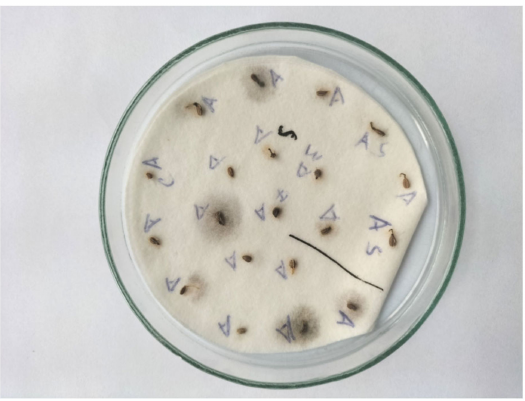
Figure 3. Petri dish with carrot seeds after examination of seed health. Parameters characterizing seed vigor T 1 , T 25 , MGT and U 75-25 were evaluated using SeedCalculator 2.1. [48]. All results were evaluated using Statistica, by a one-way analysis of variance after transforming percentage values according to Bliss’ formula: y = arc sin [sqr (x/100)]. Means were compared with the Duncan’s multiple range test at the level α =